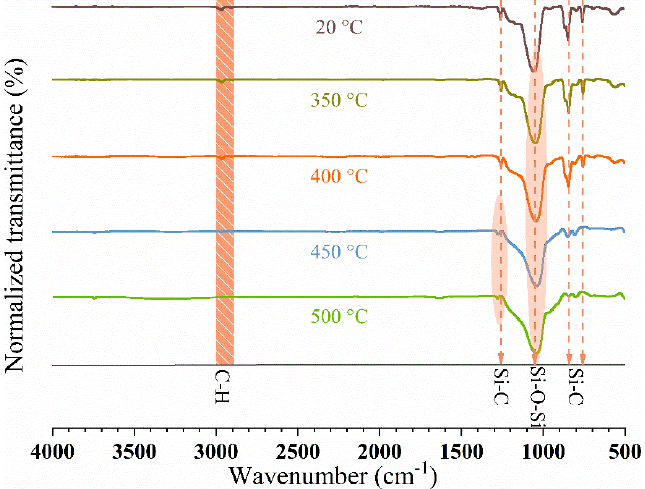
Figure 9. FTIR spectra of LDH/SA-10% by heat treatment at various temperatures.